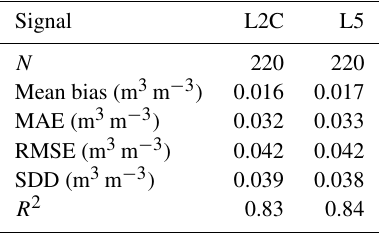
Table 3. Soil moisture scores between daily mean in situ VSM ob- servations at a depth of 5cm and GNSS VSM retrievals (either L2C or L5) during TS1 (SNR data from the 29.4m antenna with 10s sampling interval from 1 August 2015 to 18 March 2016). MAE, RMSE, SDD and N are defined in Table